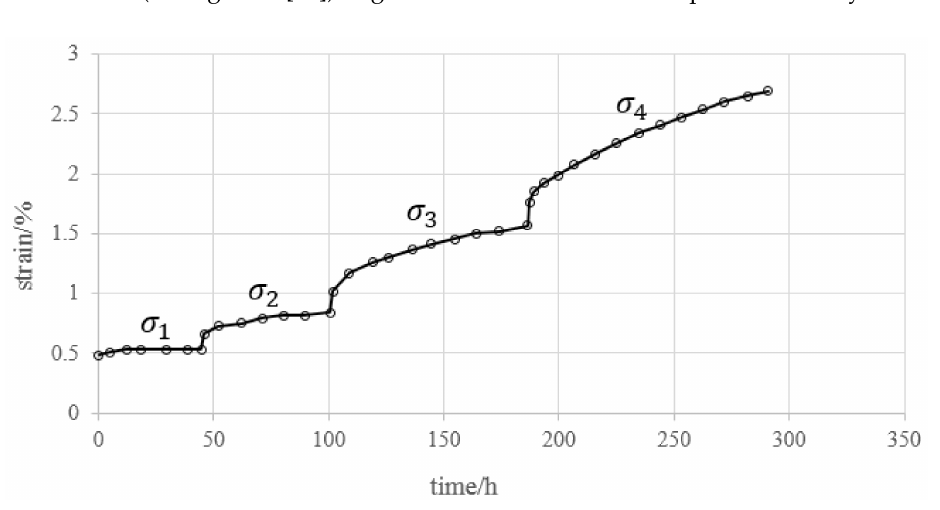
Figure 14. Tri-axial creep curves of anhydrite rock salt (after Zhang et al.